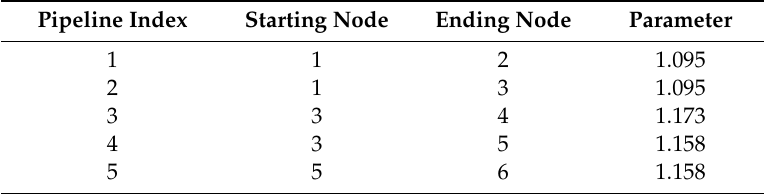
Table 3. Pipeline parameters of the natural gas network.